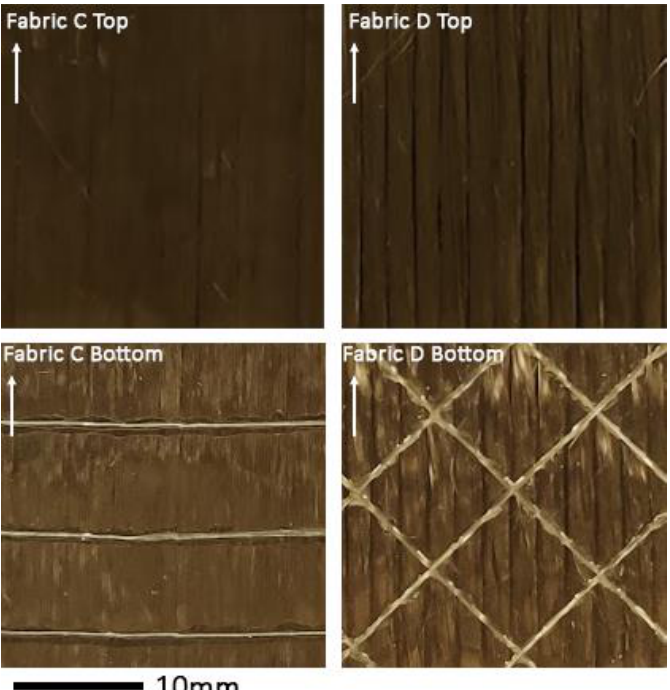
Figure 2. Top and bottom views of the two distinct types of fabrics. Fiber direction is indicated with arrows.